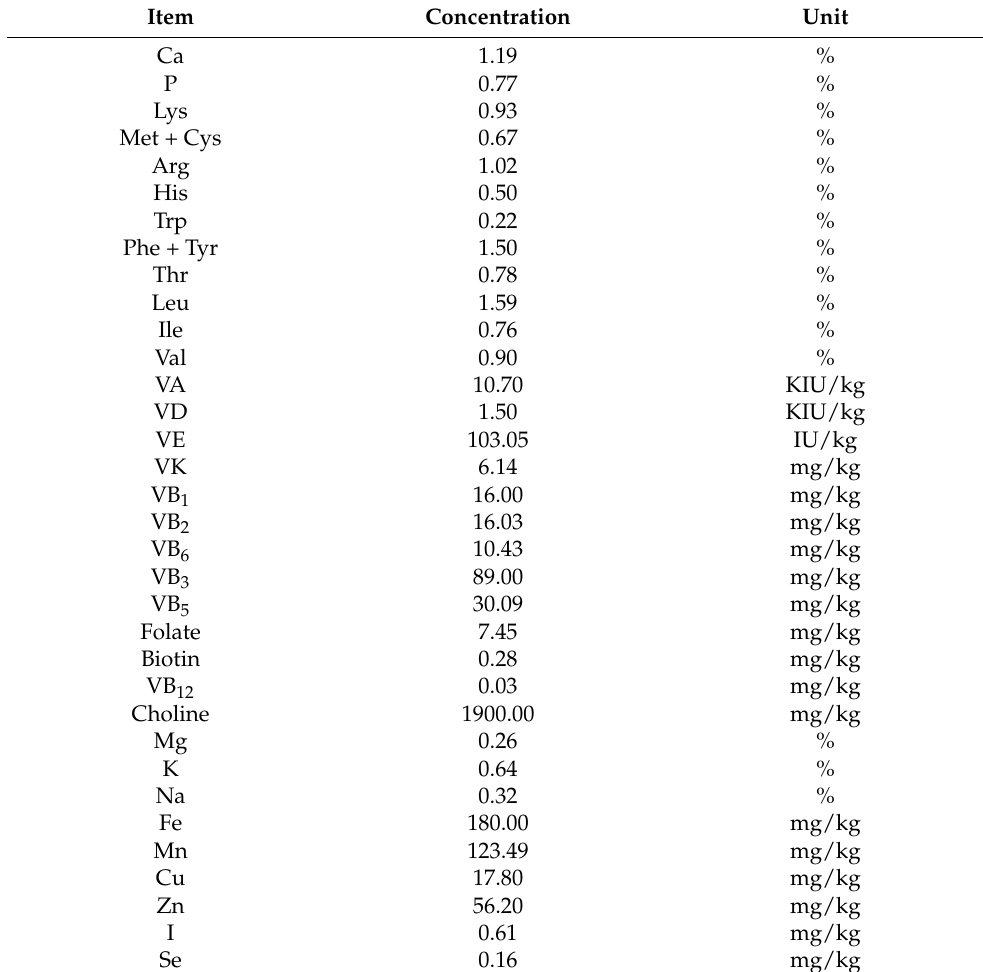
Table 2. The concentrations of nutrients and trace elements in normal fodder. Item